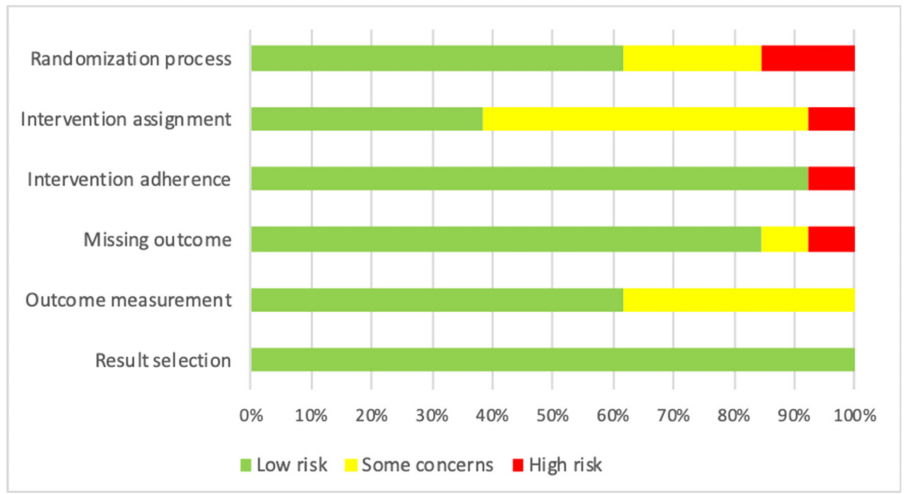
Figure 2. Risk of bias graph as percentage across all included